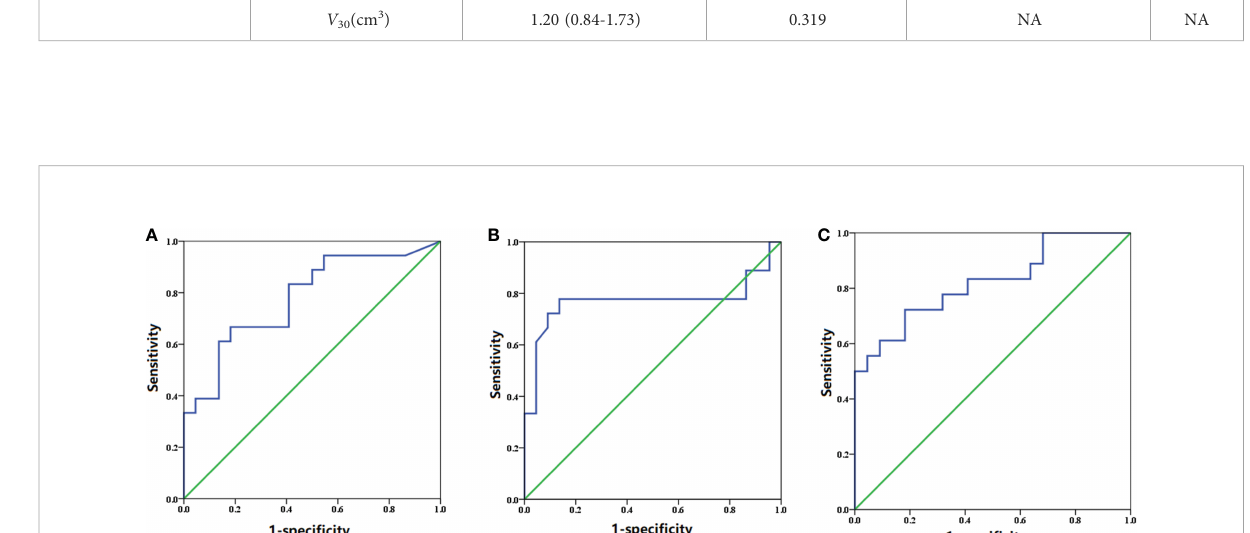
FIGURE 3 ROC curve of the (A) V 10 of the stomach, (B) D mean of the intestine, and (C) combination of the two